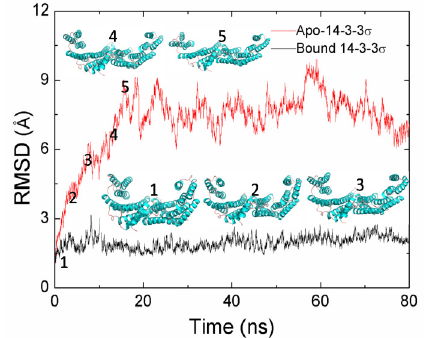
Figure 2. RMSDs of backbone atoms of 14-3-3 protein as a function of the MD simulation time. Five snapshots extracted from the first 20 ns MD simulation of apo-14-3-3 σ